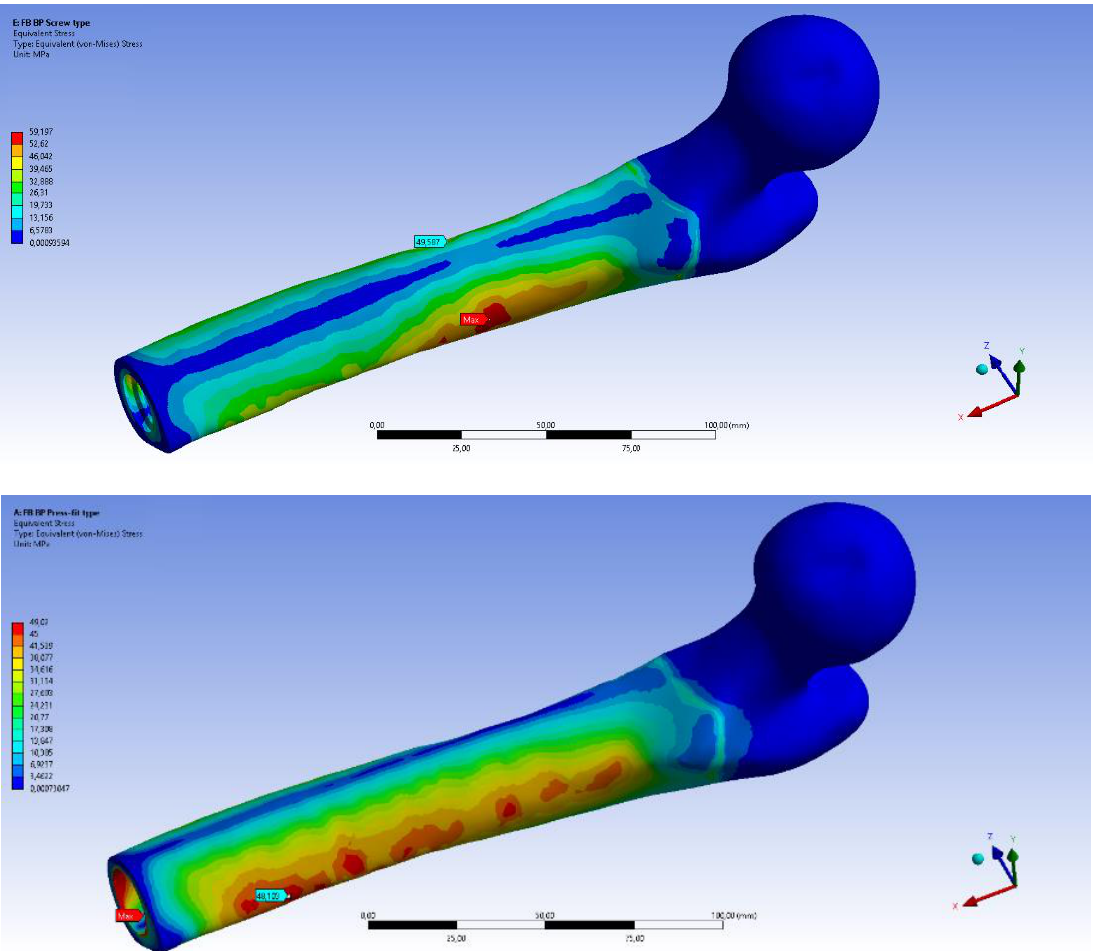
Figure 12. Fall Forward with Balance Loss (FF BL) scenario: von Mises stress distribution on femur using the OPRA ( top ) and the OPL ( bottom ) device